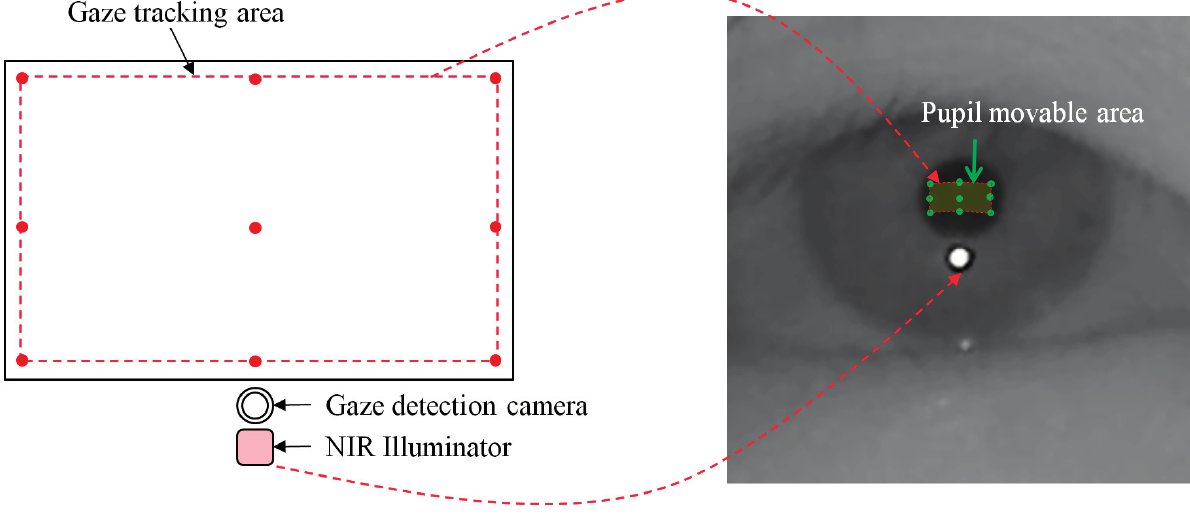
Figure 12. The possible area of gaze